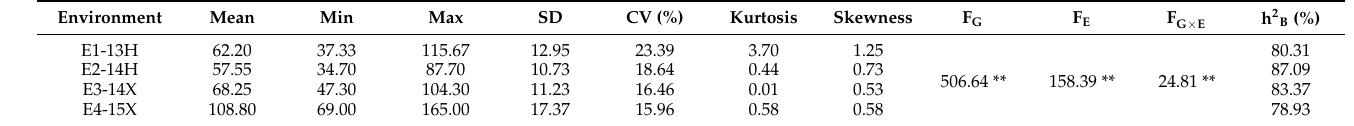
Table 1. Descriptive statistics for plant height in 94 tobacco accessions in four environments.